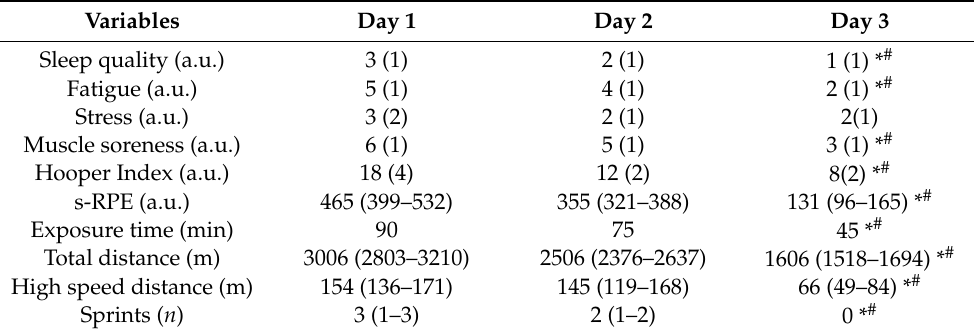
Values are group means and 95% confidence interval (CI) estimates for workload metrics, and group median and interquartile ranges for perceived well-being indices. * Significantly different from day 1 ( p < 0.05); # Significantly different from day 2 ( p < 0.05). Abbreviations: s-RPE, session-rating of perceived exertion; HSD, high-speed distance; a.u., arbitrary units. The within-subject correlations between workload metrics and perceived well-being indices are presented in Figure 1.